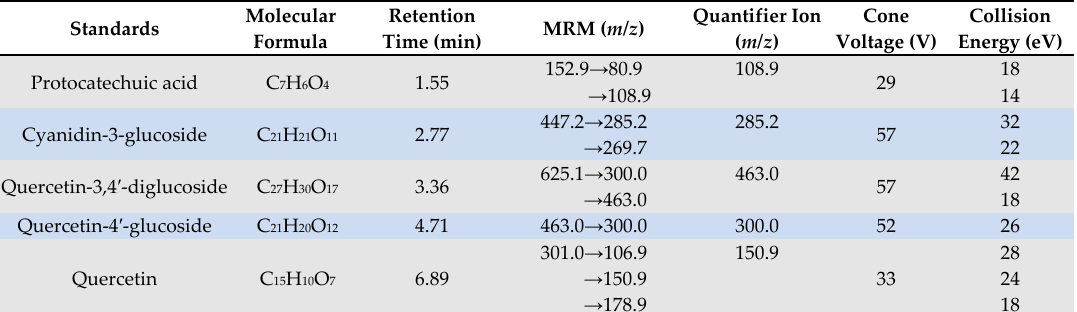
Table 1. MRM transitions, cone voltage and collision energy for determination of the polyphenols.